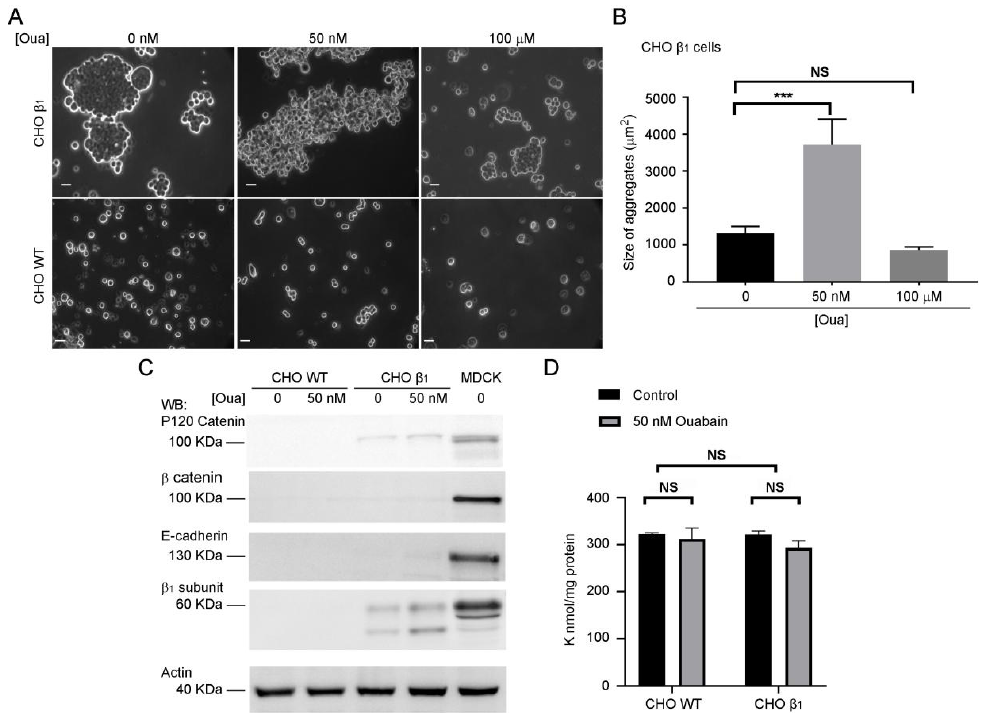
Figure 2. Low doses of ouabain increased cell-cell adhesion of CHO β 1 cells. ( A ) Representative microscopy images of cell aggregation of CHO β 1 cells (upper panels) and CHO WT cells (lower panels) treated with ouabain (50 nM, 100 µ M). Scale bar = 20 µ m. ( B ) Quantification of the mean size of cellular aggregates of CHO β 1 cells treated with 0, 50 nM and 100 µ M ouabain based on three independent biological replicates. One way ANOVA and Dunn’s tests for multiple comparison were performed. Bars represent ± SE; NS, non-significant, *** p < 0.0001. ( C ) Representative Western blot analyses of the adhesion markers p120 catenin, β catenin, E-cadherin, and the β 1 subunit of the sodium pump in CHO β 1 and CHO WT cells, untreated or treated with 50 nM of ouabain. MDCK cells were used as positive control. Actin was used as loading control. ( D ) Whole cell content of K + was determined by AAS from CHO β 1 and CHO WT cells treated with 50 nM of ouabain for 24 h. The average of three independent biological replicates is depicted. One-way ANOVA and Dunn’s tests for multiple comparison were performed, bars represent ± SE, NS,